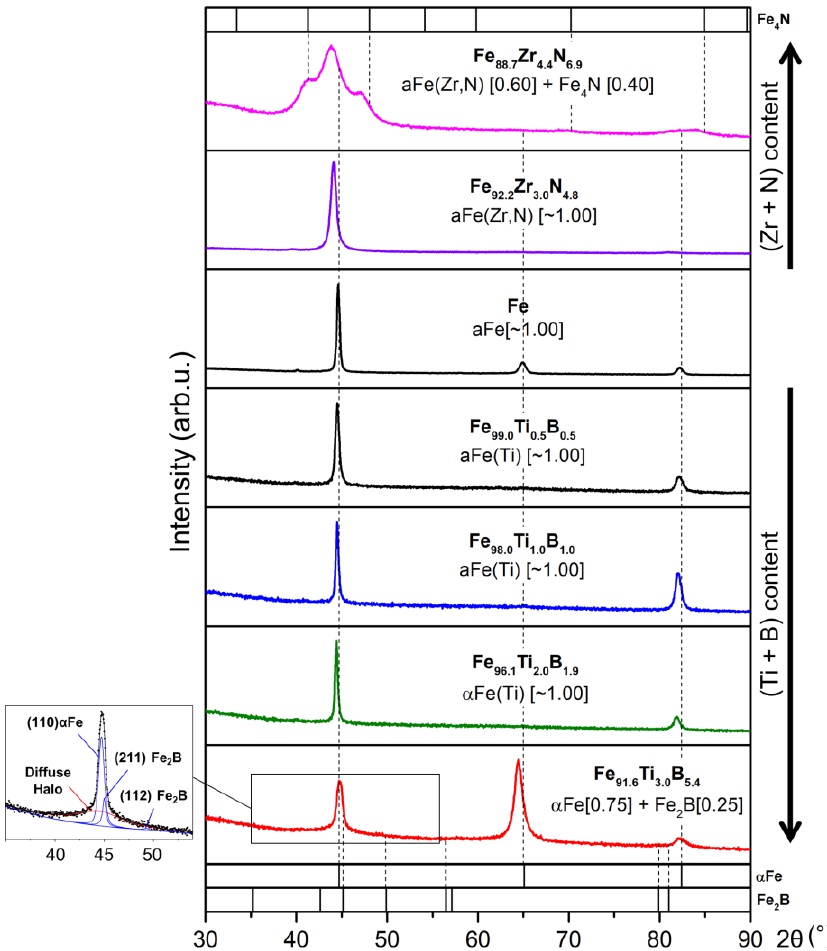
Figure 3. XRD patterns of the as-deposited films under study.